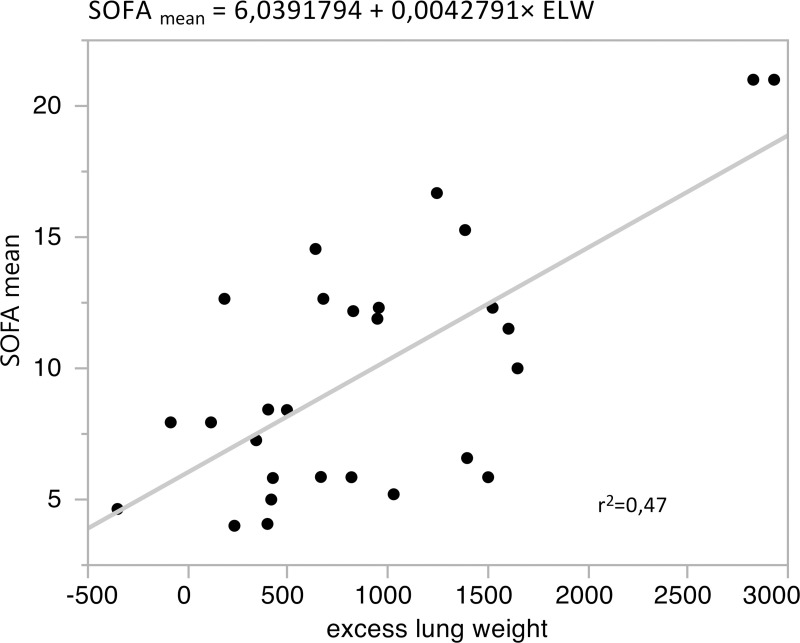
Correlation between excess lung weight and SOFA mean. p <0.0001; r = 0.69.